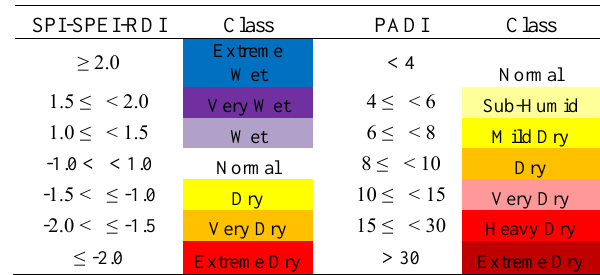
Table 2. Classification used for SPI, SPEI, and RDI (left), and for PADI (right). This table also represents the legend for Fig.